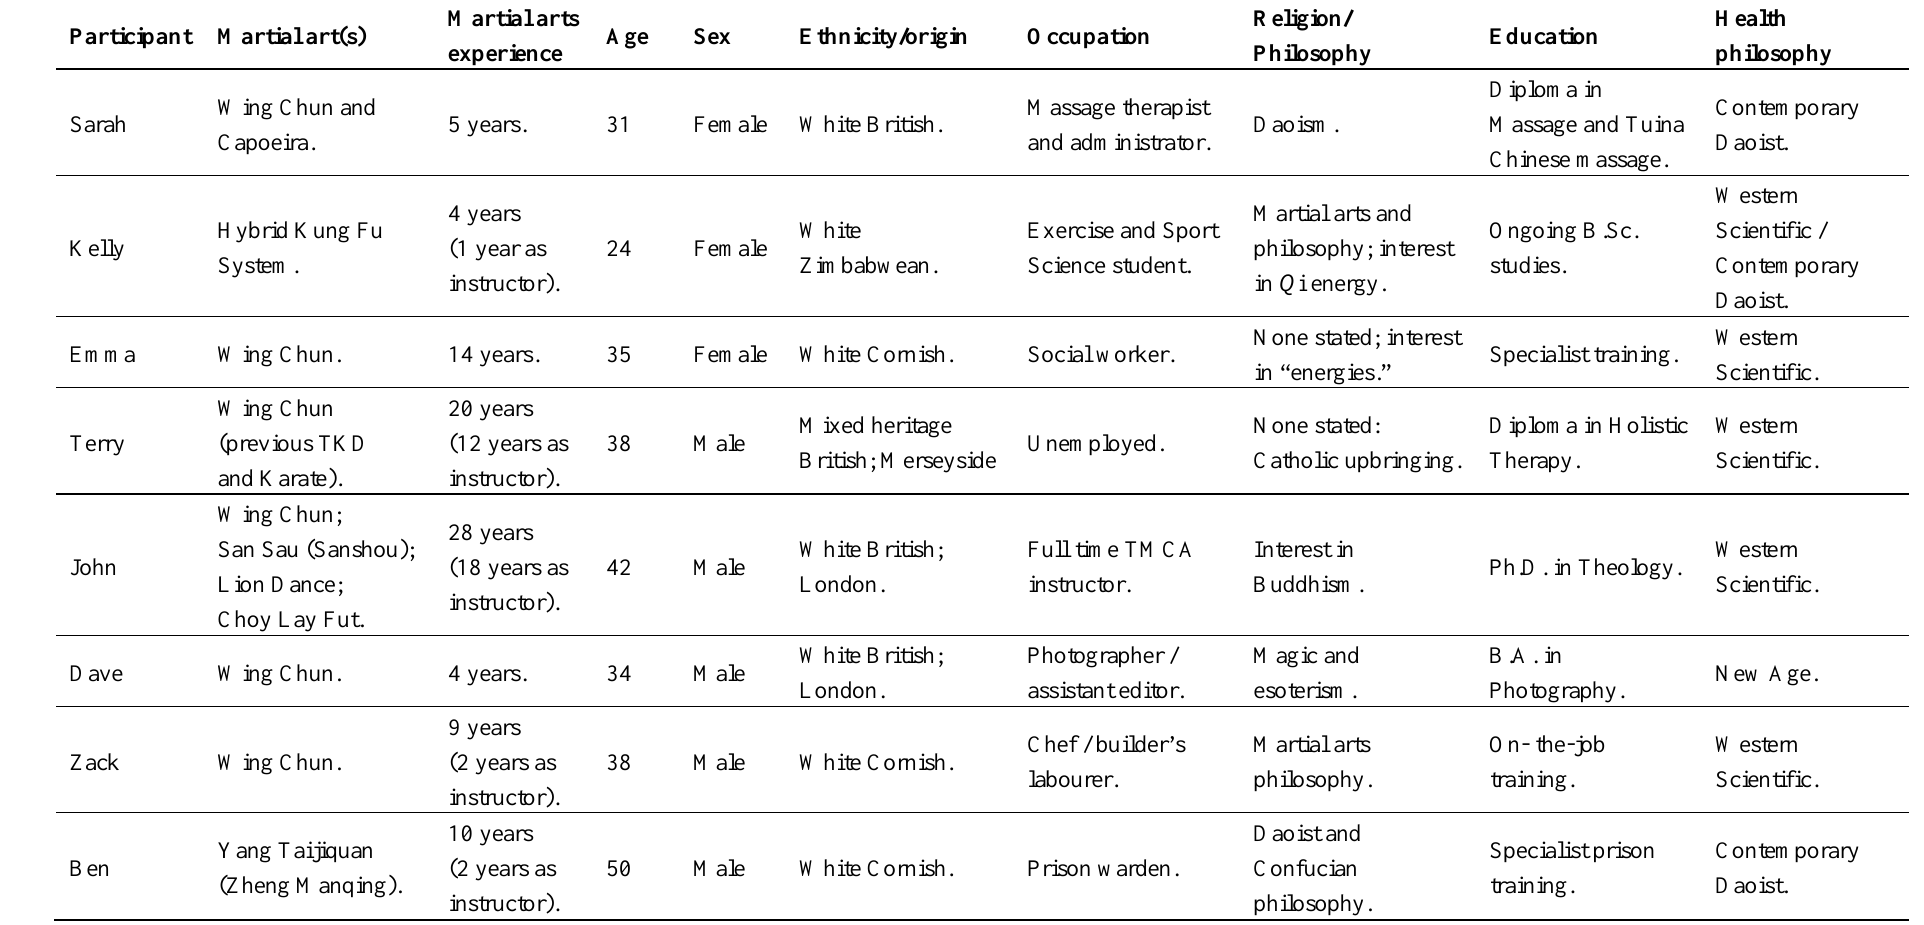
Table 1. Socio-demographic details of remaining research